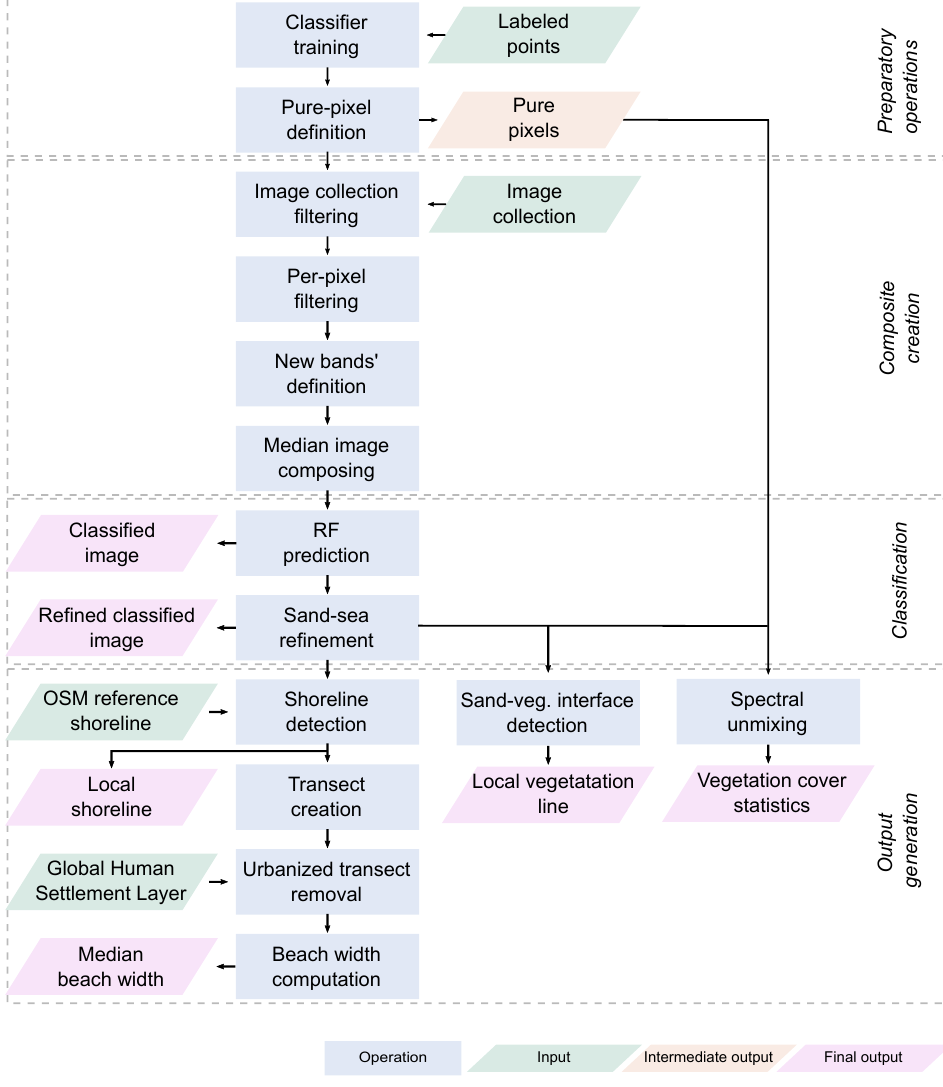
Figure 2. Algorithm’s workflow to classify satellite images and provide relevant information about coastal areas. Green boxes represent input, blue boxes represent operations, whereas orange and pink boxes represent intermediate and final output,